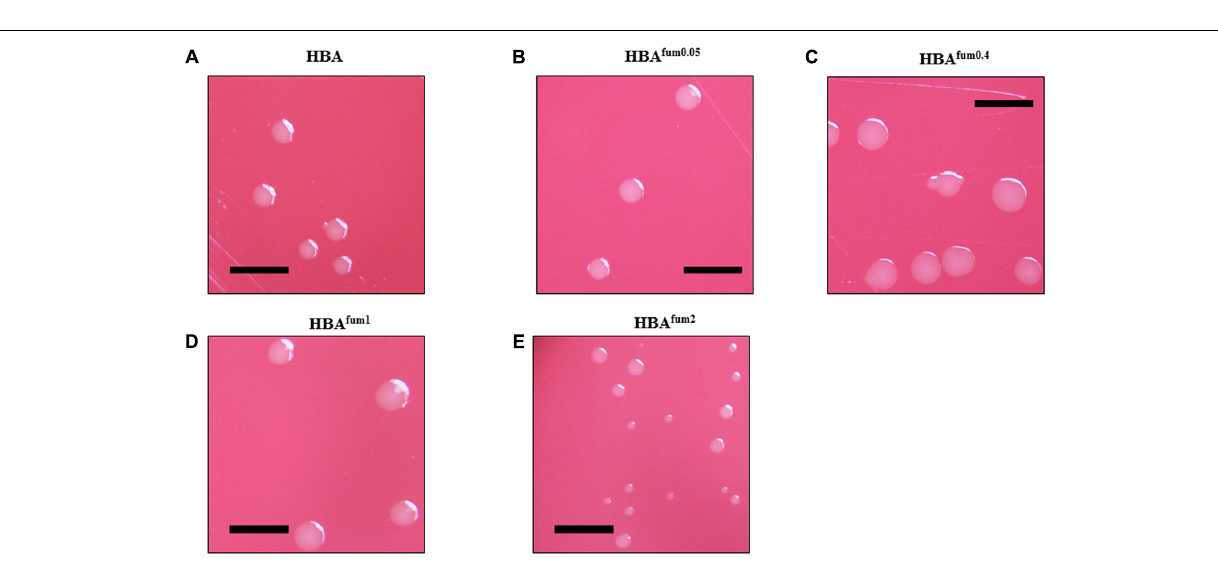
FIGURE 3 | The effects of sodium fumarate on the colony size of C. concisus . Colonies of representative C. concisus strain H14O-S1 on HBA plates (A) without supplementation and (B–E) with supplementation of sodium fumarate at 0.05, 0.4, 1, and 2%, respectively. Scale bars represent 5 mm. A total of 50 C. concisus strains were streaked onto HBA, HBA fum0 . 05 , HBA fum0 . 4 , HBA fum1 , and HBA fum2 . After incubation, colonies were observed under a stereomicroscope and photographs were captured at 20 ×